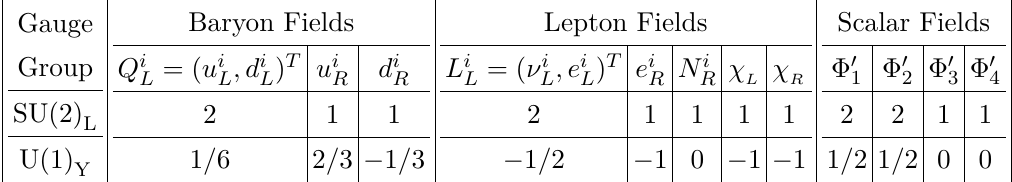
Table 2 . Particle contents and their corresponding charges under the SM gauge group.